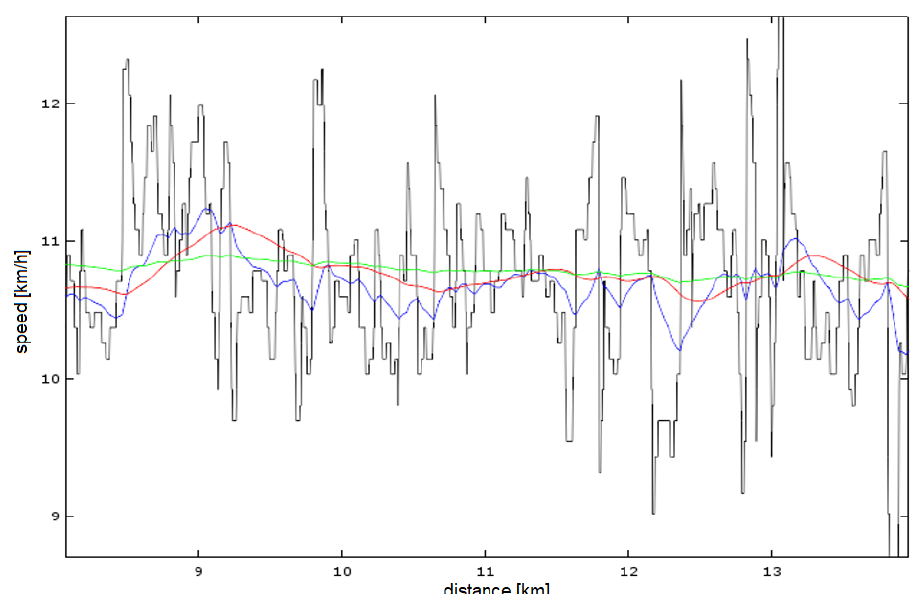
Figure 9. Quality of speed trend estimation: GNSS measurement (Samsung phone)—black, after the first IIR filter—blue, after the second IIR filter (coefficients set I)—red and after the second IIR filter (coefficients set II)—green.